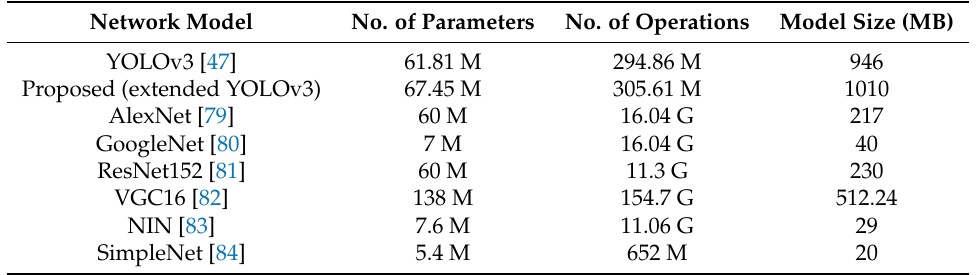
Table 6. Comparison of neural network complexity by the number of parameters, number of operations and model